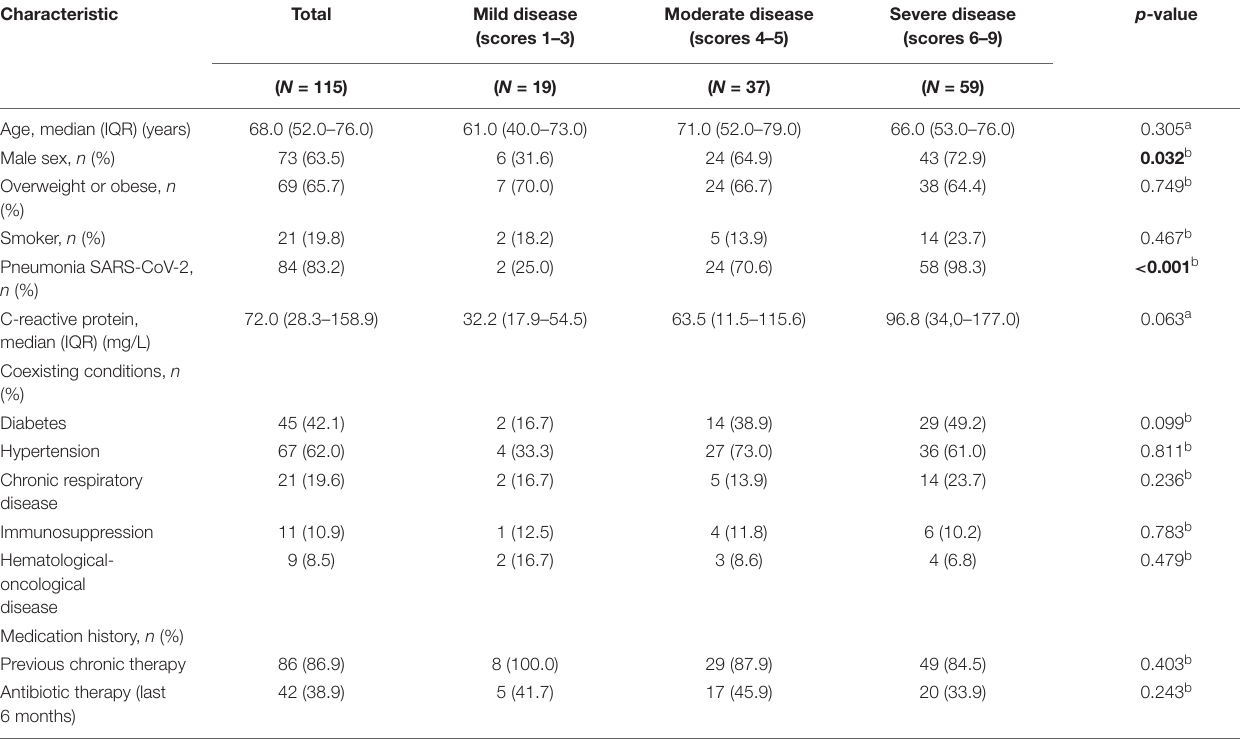
TABLE 1 | Clinical characteristics of the COVID-19